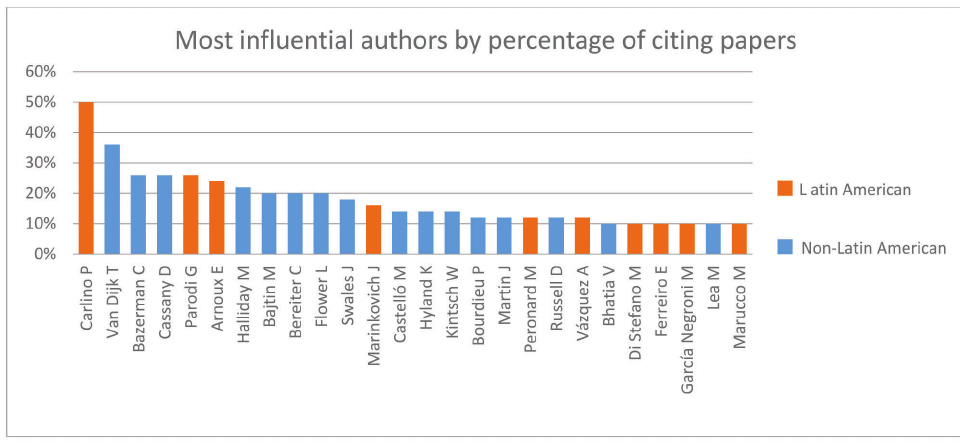
Figure 1: Influential authors by percentage of citing